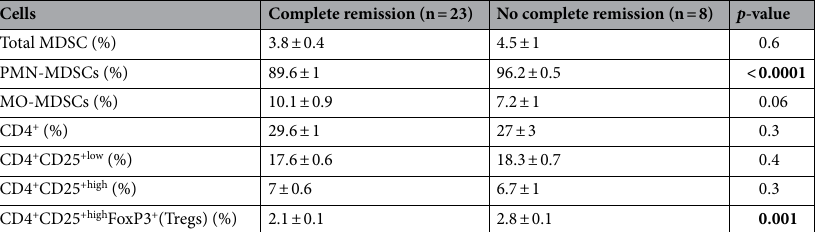
Table 4. Relation of myeloid-derived suppressor cells and regulatory T cells with the post-induction response in children with B-cell acute lymphoblastic leukemia. n number, MDSCs myeloid-derived suppressor cells, PMN-MDSCs polymorphonuclearmyeloid-derived suppressor cells, MO-MDSCs monocytic myeloid-derived suppressor cells, Tregs regulatory T cells. Results expressed as mean ± S.E. Mann–Whitney U test; significant p- value < 0.05.